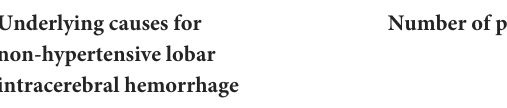
TABLE 2 Bleeding